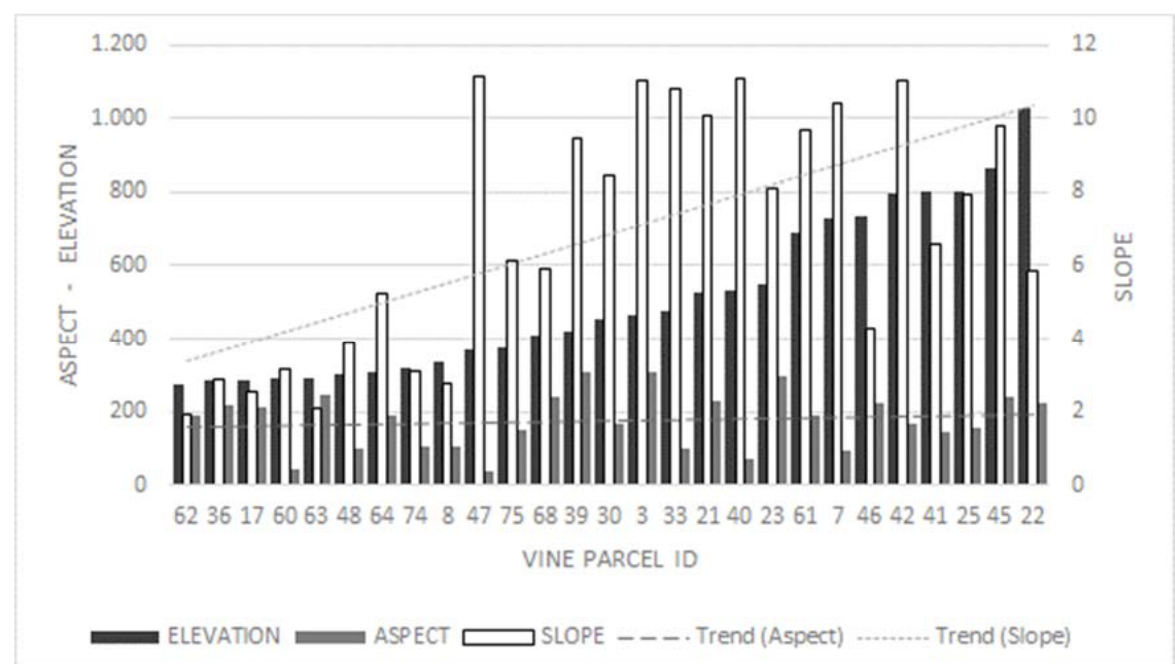
Figure 6. Topographic parameters, Elevation (meters), Slope (degrees), Aspect (degrees) of the 27 parcels, ordered by elevation.